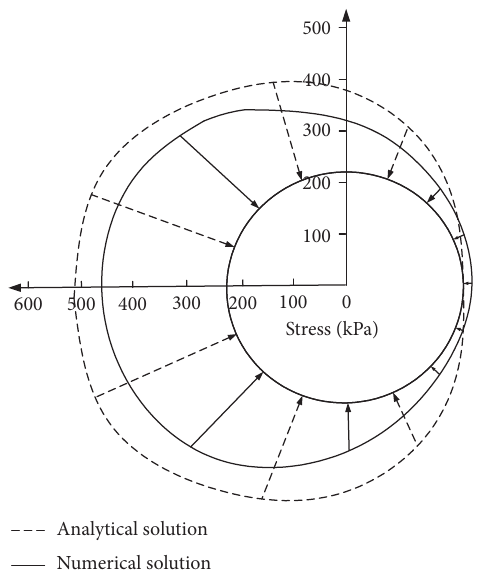
Figure 7: Analytical solution and numerical solution of the stress field around the pile (the section at 10m